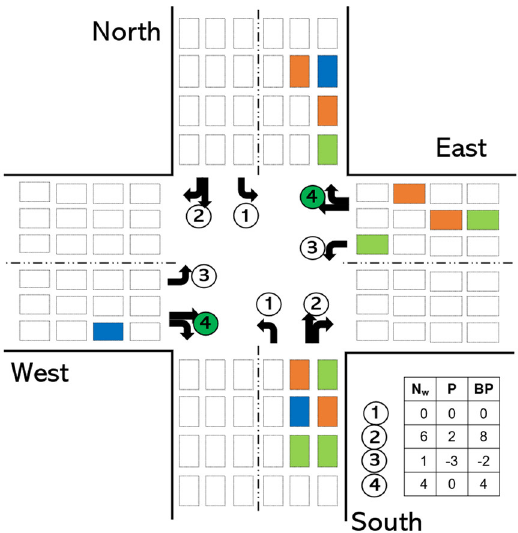
Figure 3. Example scenario to illustrate the difference of conventional pressure control and the proposed BP control. Phase #4 is set for the intersection. The table on the bottom-right corner of the figure shows the sum of approaching vehicles in the incoming lanes (denoted as N w ), pressure value (denoted as P), and BP value (denoted as BP) for all four phases.